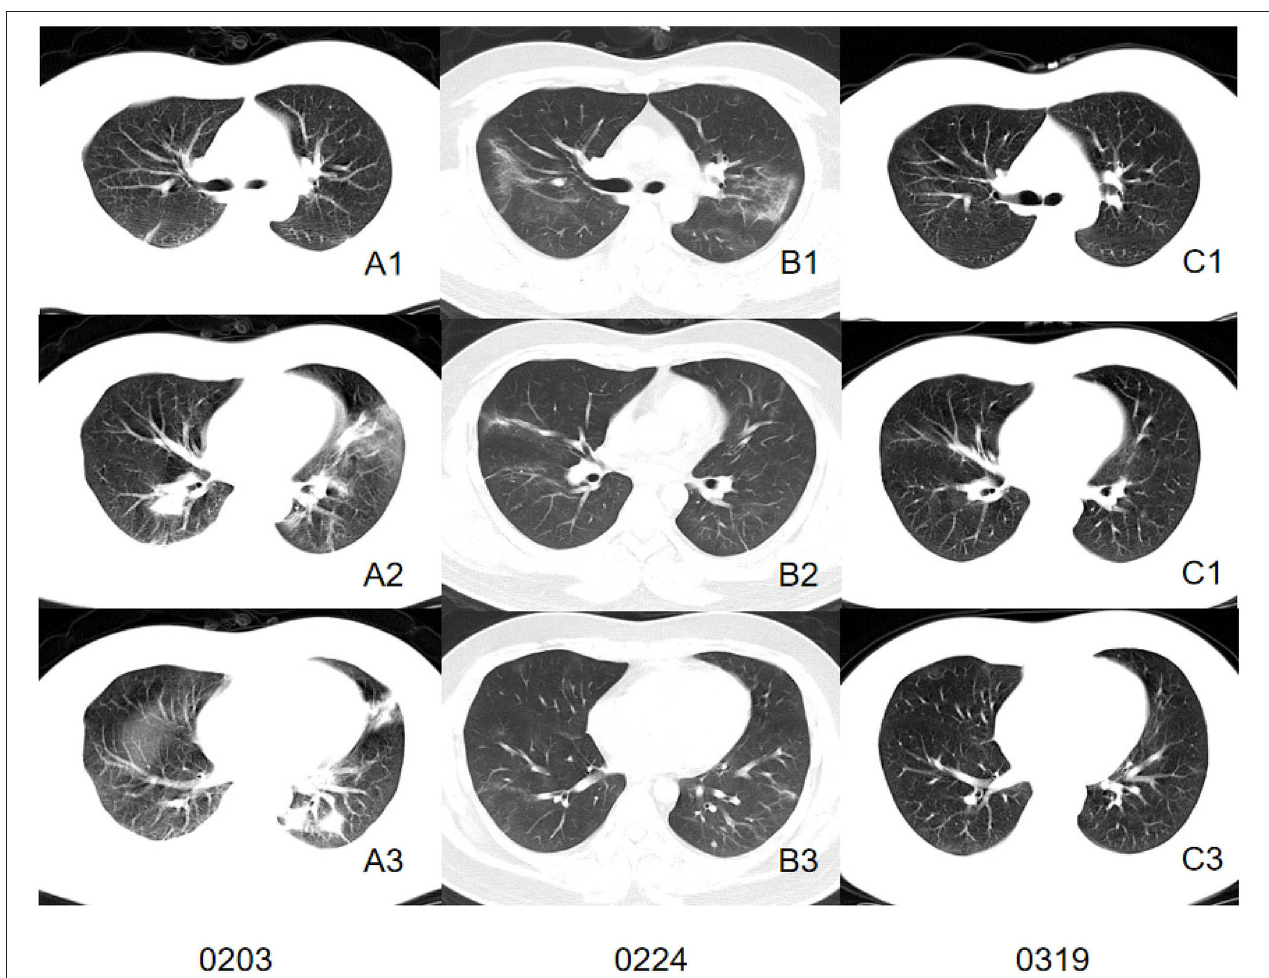
FIGURE 3 | CT images of a patient in control group. Initial CT imaging (A1–A3) obtained on Feb 3 showed multiple mixed GGO and consolidation with bilateral, peripheral, and predominately lower lung involvement. Interlobular septal thickening and reticulation were not found. Follow-up CT when discharged (B1–B3) showed absorbed lesion. A follow-up CT conducted 24 days after discharged (C1–C3) showed completely absorbed